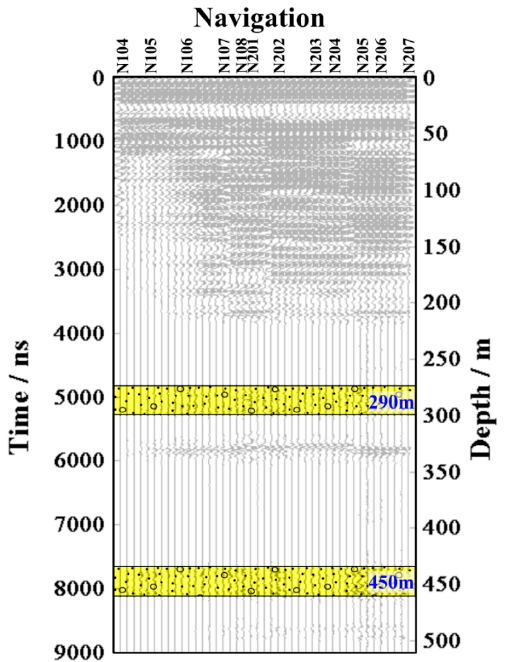
Figure 11. Interpretation of the data.